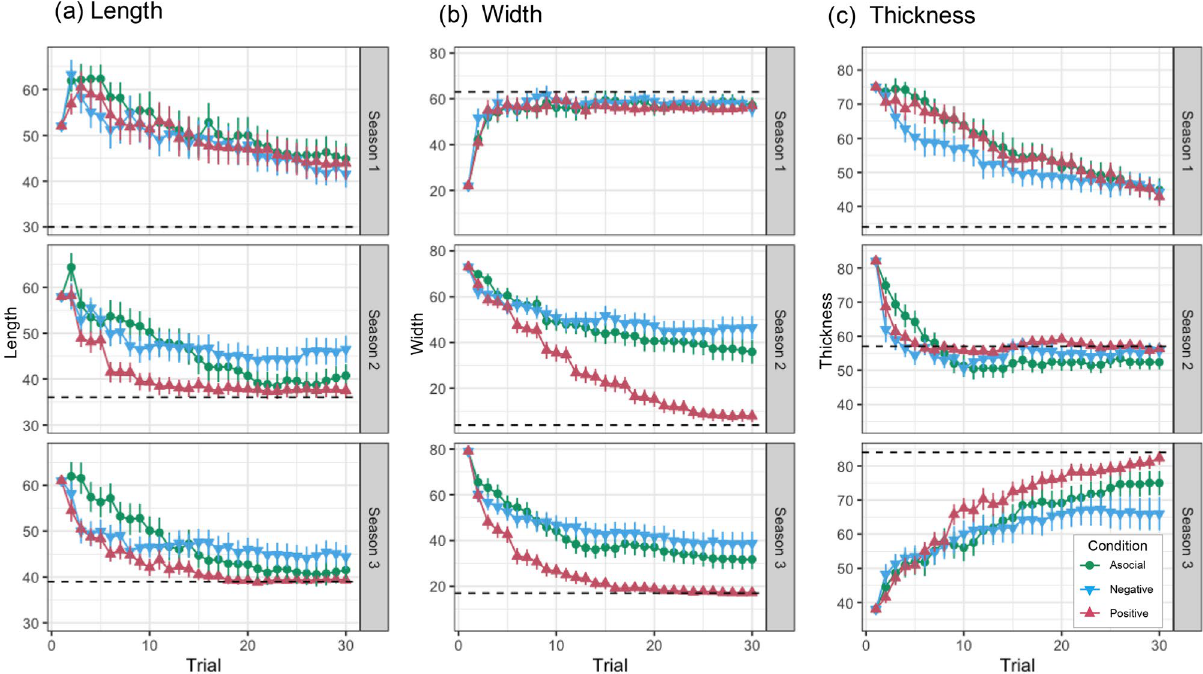
Figure 2. Shifts in the values of length ( a ), width ( b ), and thickness ( c ) across 30 trials. The dotted lines show the optimal value (global optimum) for each attribute. Error bars show standard errors.